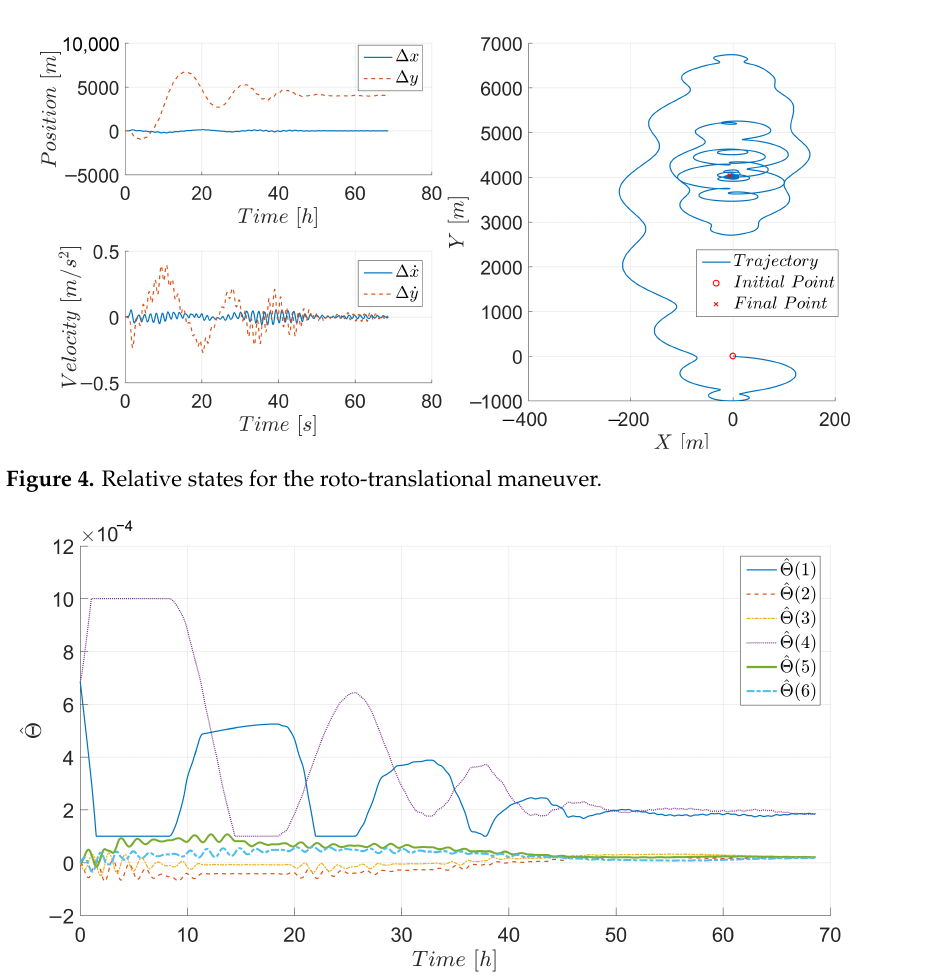
Figure 5. Parameter estimates from the relative maneuvering